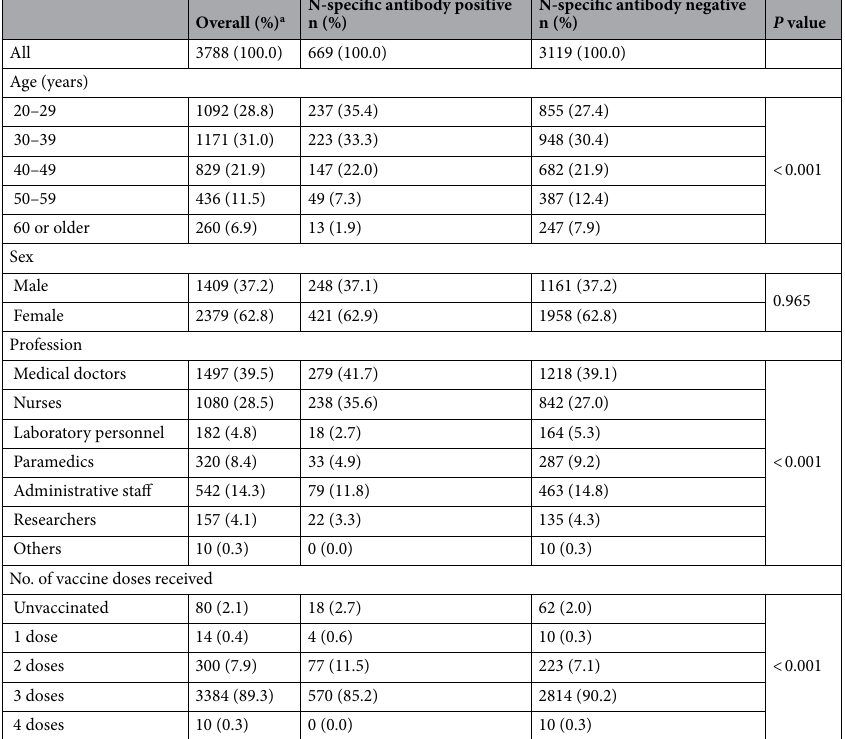
Table 1. Basic characteristics and N-specific antibody results (positive vs. negative). a Numbers of participants by categories in this table indicate the status at the time of the 2022 health check-up, conducted from June 8 to June 20 in Juntendo University Hospital of Tokyo, Japan. A two-tailed p < 0.05 was considered